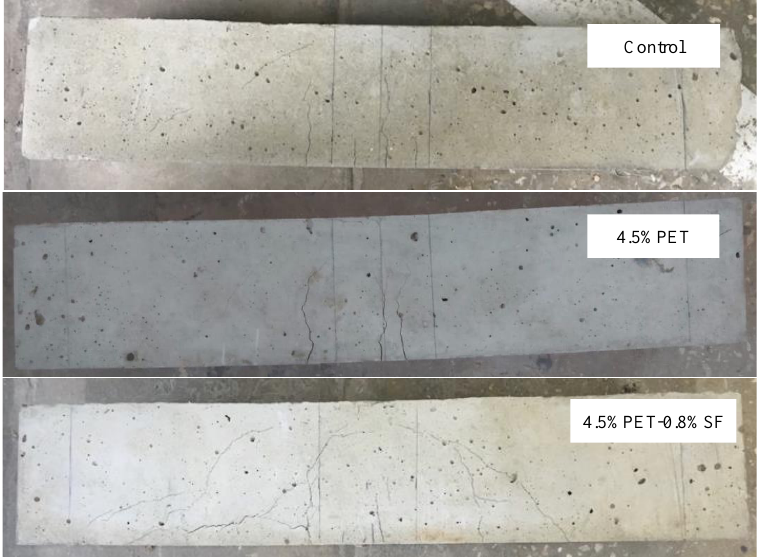
Figure 4. Crack patterns for selected beams after failure (i.e., flexure testing).